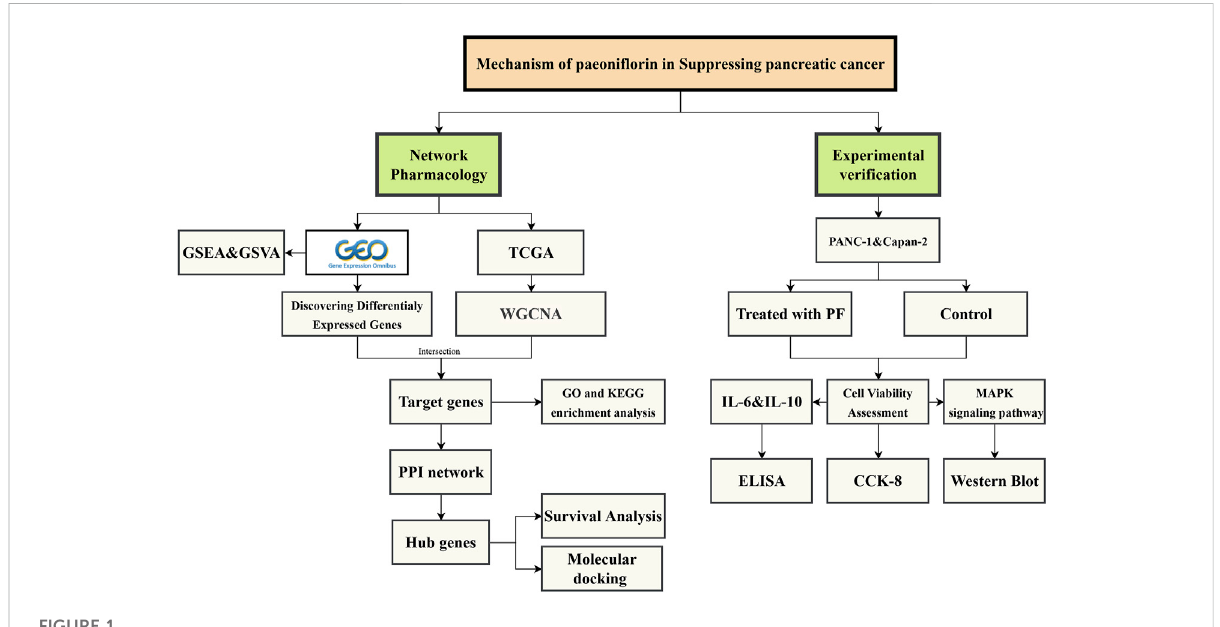
FIGURE 1 The work fl ow of this